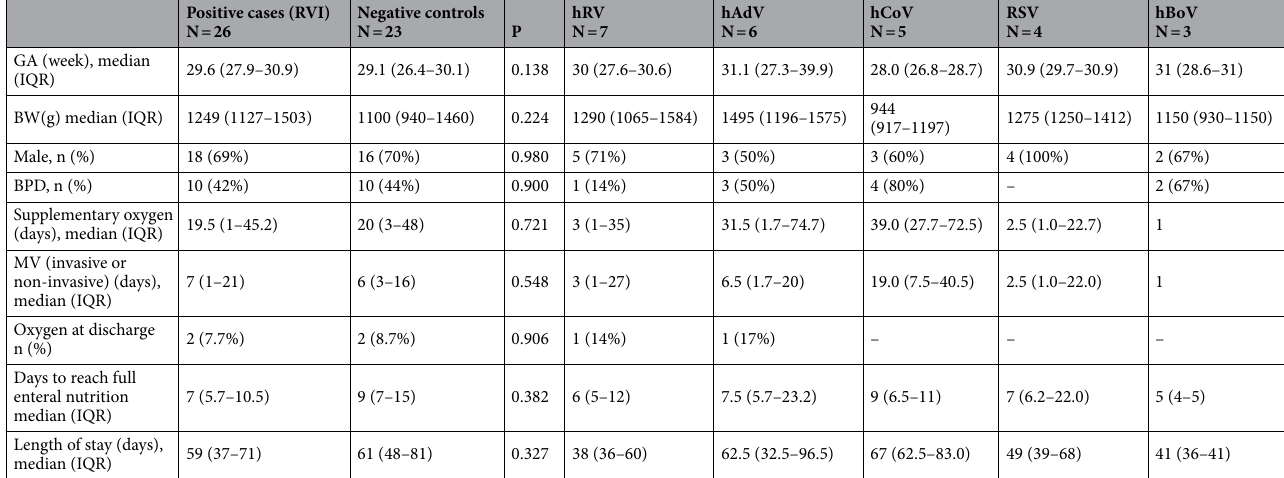
Table 1. Demographic and relevant clinical data of the study population (RVI group and controls). GA gestational age, wk weeks, BW birth weight, BPD bronchopulmonary dysplasia, g grams, IQR interquartile range, MV mechanical